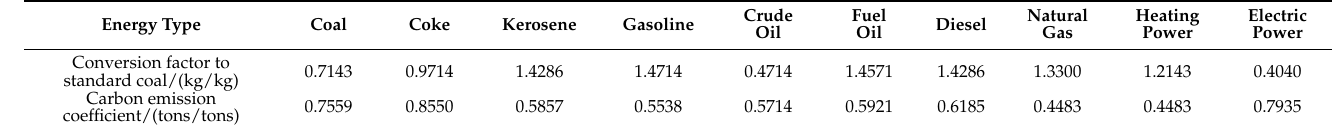
Table 4. Carbon emissions intensity is calculated as the carbon emissions per unit of GDP. Table 3. Urban space carbon emission measurement coefficient.